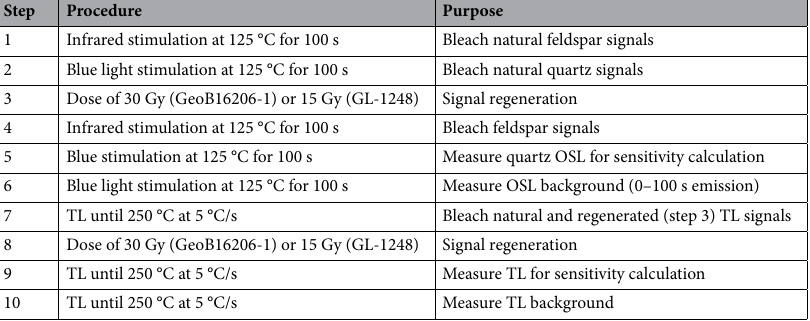
(based on planktonic foraminifera Globigerinoides ruber and Trilobatus sacculifer , handpicked from the fraction larger than 150 μm) and visual alignment of Ti/Ca values with the δ 18 O from North Greenland Ice Core Project (NGRIP). The IntCal13 41 curve was used to calibrate radiocarbon ages and a reservoir age of 400 ± 200 years (2σ) was applied with no additional local reservoir effect (ΔR = 0). Age model was constructed using linear interpola- tion with the software clam 2.2 42 . Further details regarding GL-1248 age model can be found in 17 . Quartz TL and optically stimulated luminescence (OSL) sensitivities follow the same variation trend 43 and both variables have been used for sediment tracing analysis 44,45 . A proxy based on a single and stable mineral such as quartz is also advantageous to avoid spurious effects related to grain-size variation or post-depositional pro- cesses. Preparation and luminescence measurements of sediment samples from marine sediment core GL-1248 followed the procedure applied to marine sediment core GeoB16206-1, previously published in Ref. 21 . Sediment samples (154 in total) were collected with 2 cm wide scoops at every 10 cm from the uppermost 16 m of the marine sediment core. Samples were oven ‐ dried at 60 °C, precisely weighted to 0.5 g and treated with H 2 O 2 27% and HCl 10% to remove organic matter and calcium carbonate (CaCO 3 ), respectively. Between chemical treat- ment, samples were washed with distilled water twice to remove the chemical reagents. We used a centrifuge to accelerate the deposition of suspended material and improve silt/clay recuperation during the distilled water washing steps. The remaining content was diluted in alcohol for luminescence measurements. Three aliquots per sample were mounted on stainless steel discs with four drops of the homogenized solution of alcohol and silt/ clay sediments (close to 2 mg of sample per disc). Stokes settling time was considered to ensure that only grains of silt/clay (< 0.063 mm) were collected with the pipette used to mount the discs. GL-1248 and GeoB16206-1 luminescence measurements were performed on an automated Lexsyg Smart TL/OSL reader and a RisØ OSL/TL DA-20 reader, respectively. Both luminescence readers are equipped with blue and infrared LEDs, Hoya U-340 filters for light detection in the ultraviolet band (270–390 nm) using a photomultiplier and beta radiation sources how the results were normalized allowing comparison between the marine sediment cores measured in the dif- ferent readers). Sample preparation and luminescence measurements were carried out in the Luminescence and Gamma Spectrometry Laboratory (LEGaL) of the Institute of Geosciences, University of São Paulo, Brazil. The luminescence measurement protocol applied on both marine sediment cores is described in Table 1. The used protocol recovered TL, blue OSL (BOSL) and infrared stimulated luminescence (IRSL) signals (see examples of TL, BOSL and IRSL curves on Fig. S7a–c). Since we aimed to obtain quartz TL and OSL sensitivities from a high number of fine-grained sediment samples, measurements were done in polymineral samples, without applying procedures to isolate quartz from feldspar. The IRSL at step 4 was used to reduce the contribution of feldspar grains to the OSL signal measured in step 5 (see IRSL/BOSL downcore curve in Fig. S7d). The suitability of this procedure applied to sediment provenance analysis was appraised by comparing OSL sensitivity measured in pure quartz and polymineral aliquots 44 . Additionally, the use of filters for light detection in the ultraviolet band also minimizes the effect of feldspar contamination for the OSL signal. The OSL sensitivity (Fig. S7e) was calculated from step 5 (Table 1) by integrating the first second of light emission and the last ten seconds as background (Fig. S7b). Step 6 was used to calculate the background of the total OSL emission, which was used to represent the OSL sensitivity (first second) as a percentage of the total OSL emission (0–100 s). The sensitivity representative of the 110 °C TL peak of quartz considered the 80–120 °C integration range from the TL curve (Fig. S7c) obtained through step 9 (Table 1). The 80–120 °C TL sensitivity (Fig. S7f) was calculated as a percentage of the total TL emission (0–250 °C) and using the TL curve from step 10 as background (Table 1). The mean of three measured aliquots represents the TL and OSL sensitivities of each sample.